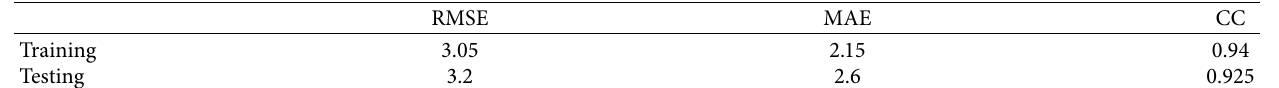
Figure 8: Error and regression charts between experimental values and simulation values calculated by EDTfor ((a), (c)) training set; and ((b), (d)) testing set. Table 2: Summary of the various performance evaluation criteria for the EDT model.